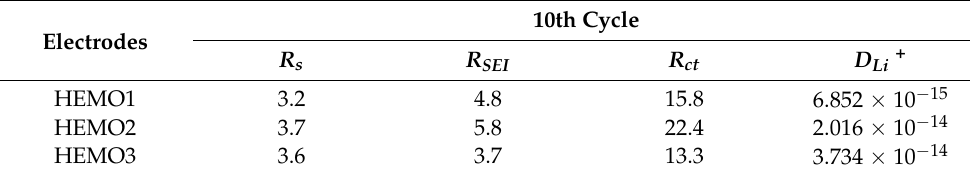
Figure 8. EIS spectra of different HEMO anodes ( a ) after 10 cycles, and ( b ) relationship between the imaginary Warburg impedance (Z’) and inverse square root of angular speed ( ω − 1/2 ) in the low-frequency region. Table 2. The fitting results of EIS parameters for HEMO electrodes at different